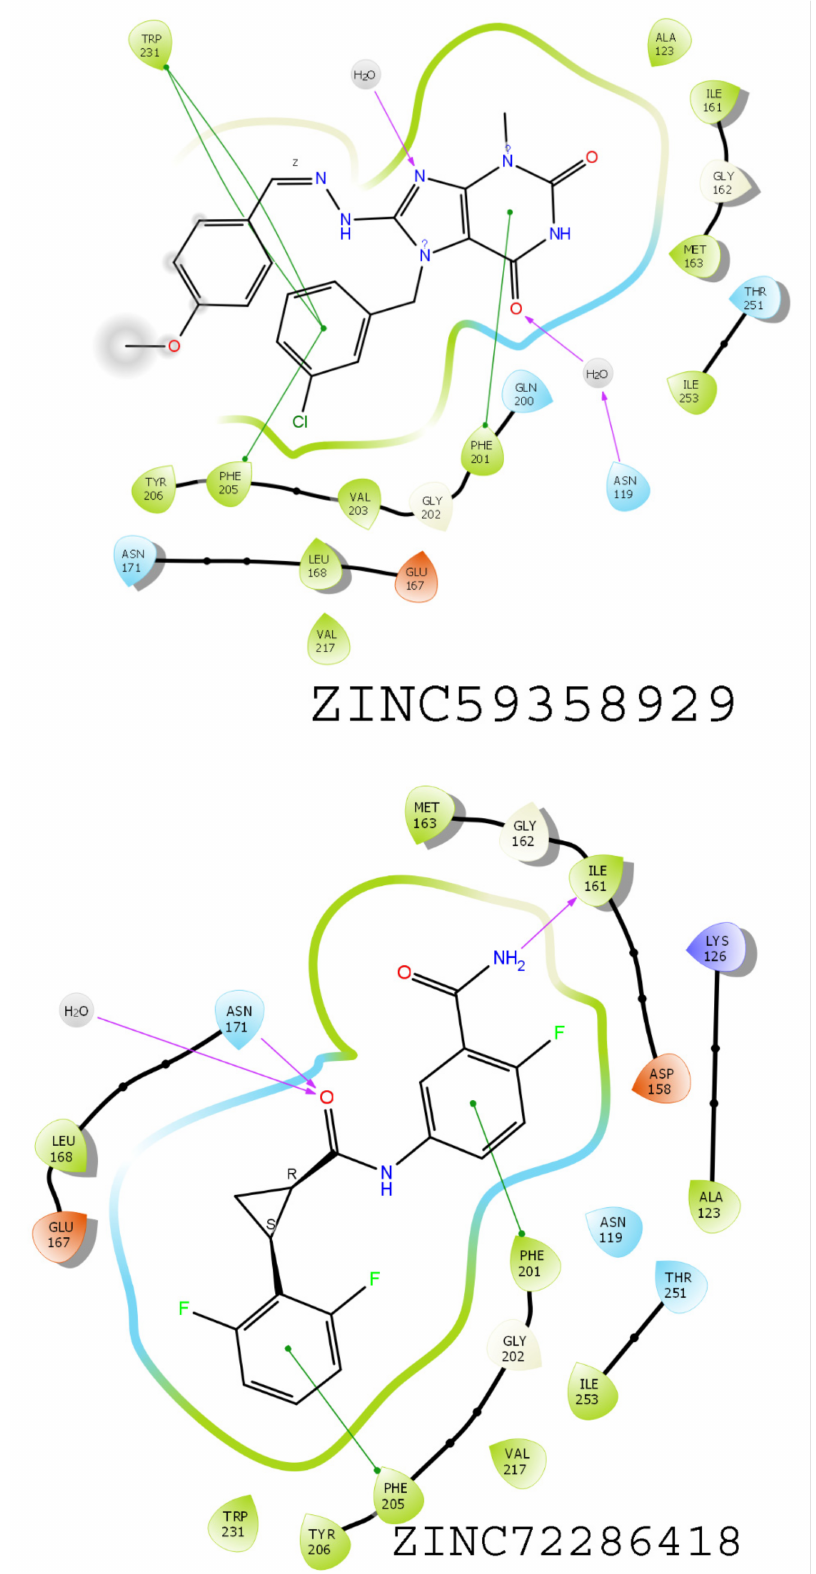
Figure 10. TRAP1(PDB ID:5Y3N) with compounds ZINC59358929 and ZINC72286418, showing binding interactions with amino